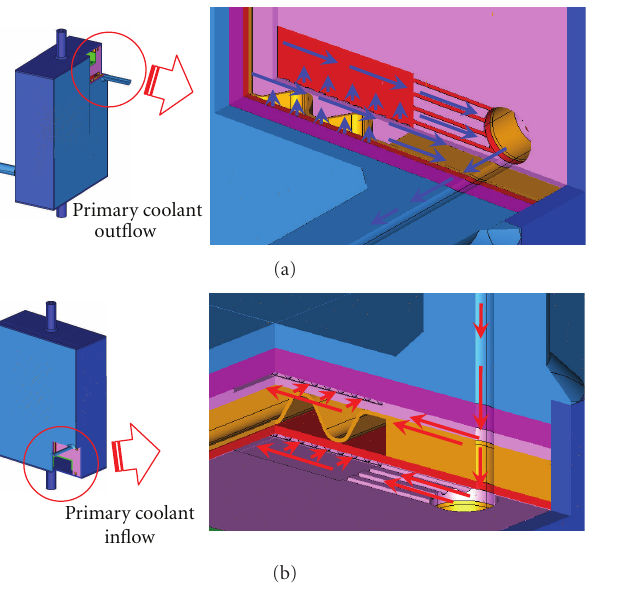
Figure 7: Inflow/outflow of primary coolant.